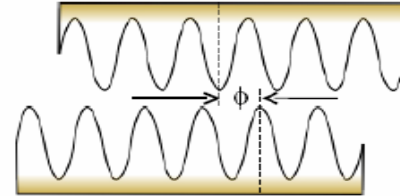
Figure 1. The schematic of two sinusoidally corrugated plates having the phase shift Φ between corrugations.